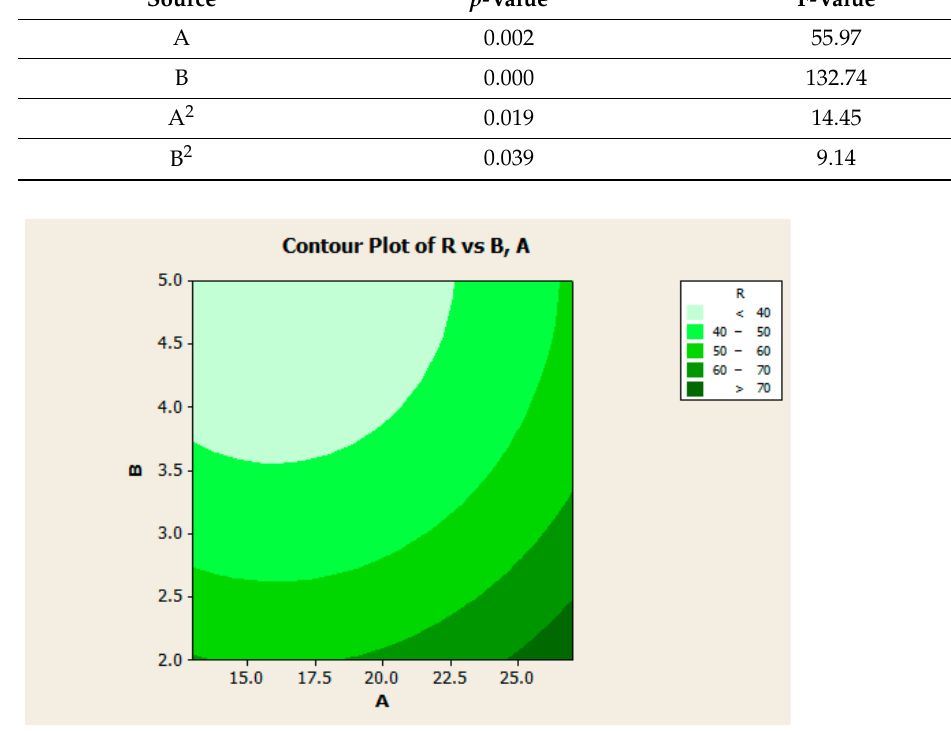
Figure 5. Contour plot for interaction between concentration of GO-Ag-CUR and volume ratio of GA to